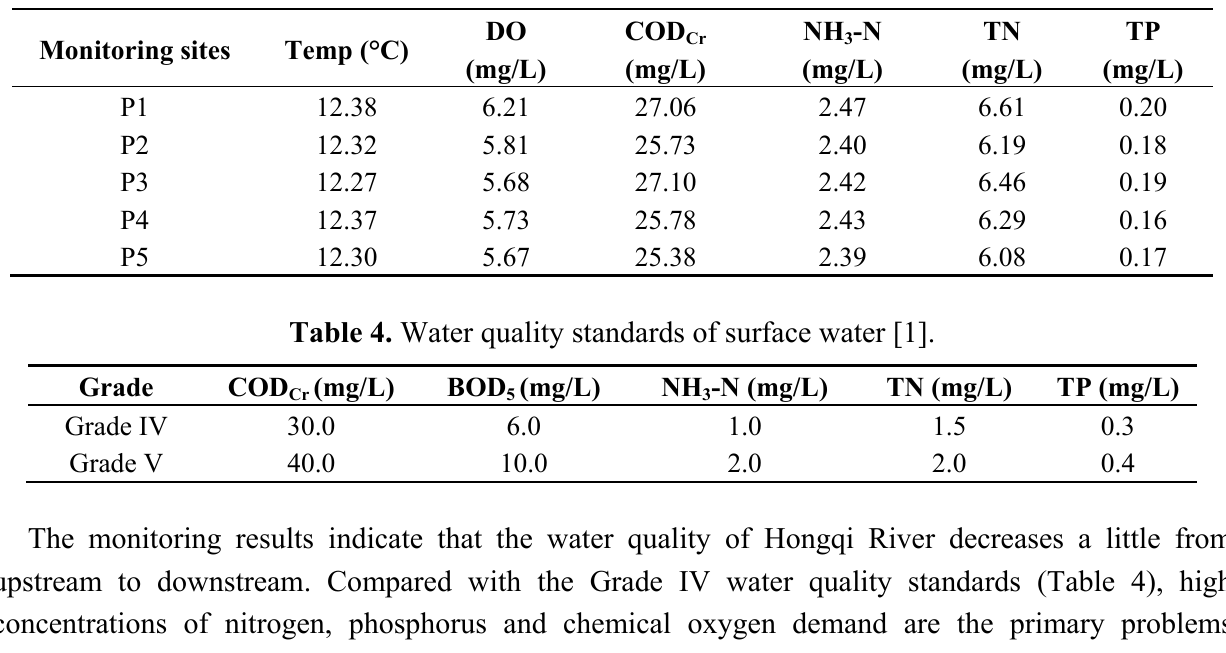
Table 3. Water quality monitoring data of Hongqi River for spring 2010.